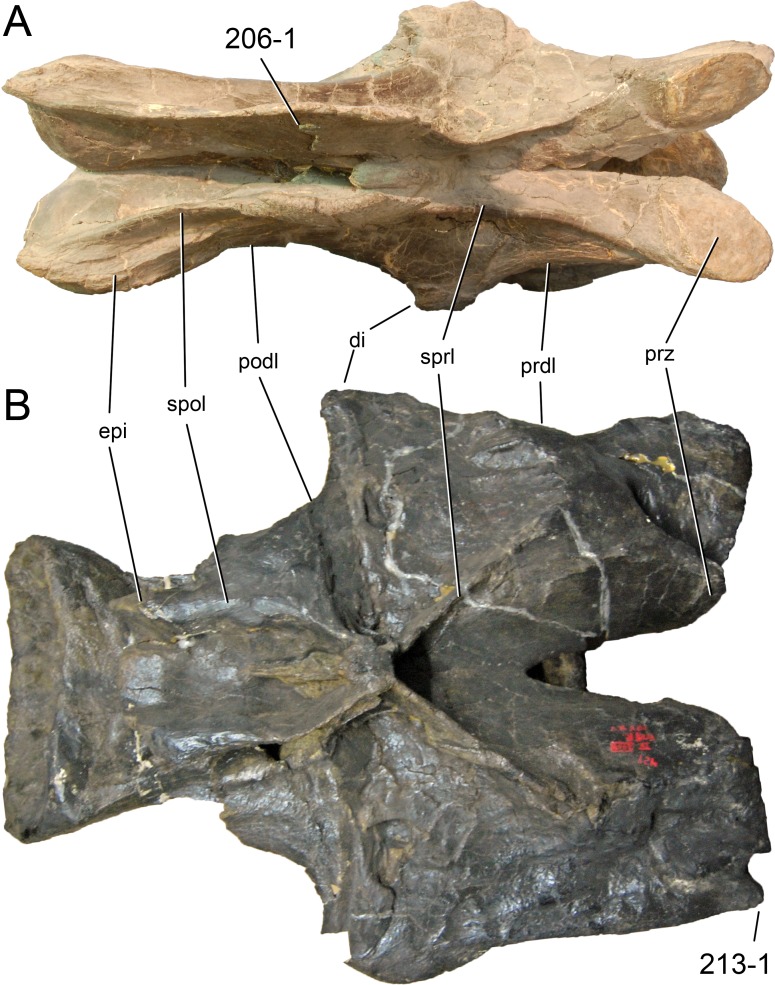
Diplodocine posterior cervical vertebrae.Posterior cervical vertebrae of Kaatedocus siberi SMA 0004 (A), and Barosaurus lentus YPM 429 (B) in dorsal view. Note the dorsoventral ridge on the medial side of the metapophysis (A; C206-1) and the anterior projection lateral to the prezygapophyseal facet (B; C213-1). Abb.: di, diapophysis; epi, epipophysis; podl, postzygodiapophyseal lamina; prdl, prezygodiapophyseal lamina; prz, prezygapophysis; spol, spinopostzygapophyseal lamina; sprl, spinoprezygapophyseal lamina. Scaled to the same total length.